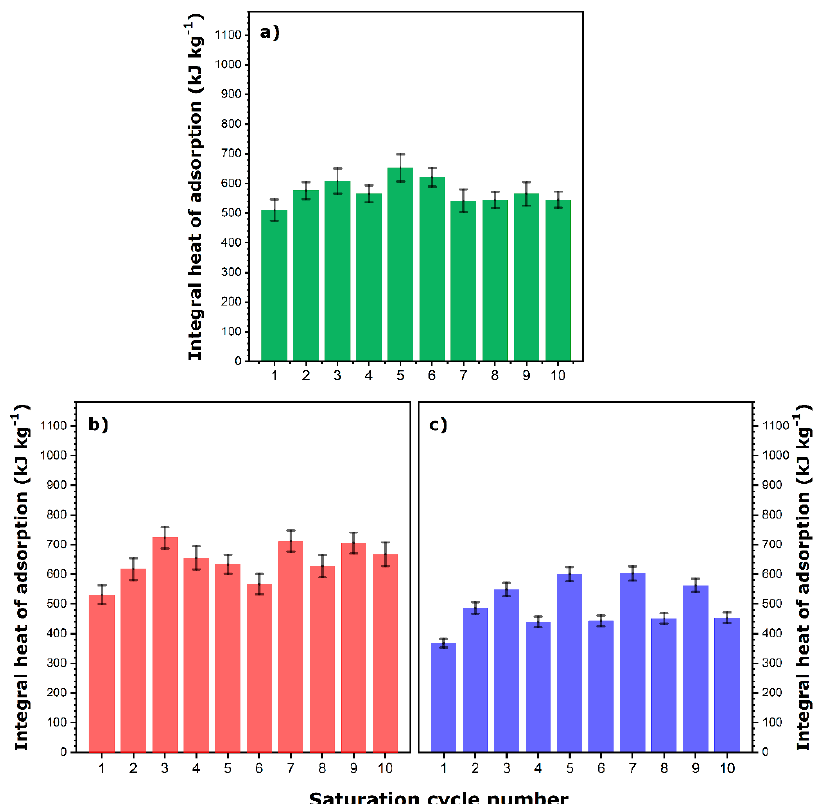
Figure 4. Integral heat of adsorption released during 10 consecutive saturation cycles for Ce-13X ( a ), Tb65-13X ( b ), and Tb95-13X ( c ) studied after a regeneration stage performed by a flow of helium at 353 K; prior to the first saturation cycle, the adsorbent was activated on-site by a vacuum treatment at 353 K for 48 h; the scale for heat is the same as that in Figure 3 to underline the differences between zeolites; error bars represent the measurement uncertainty.